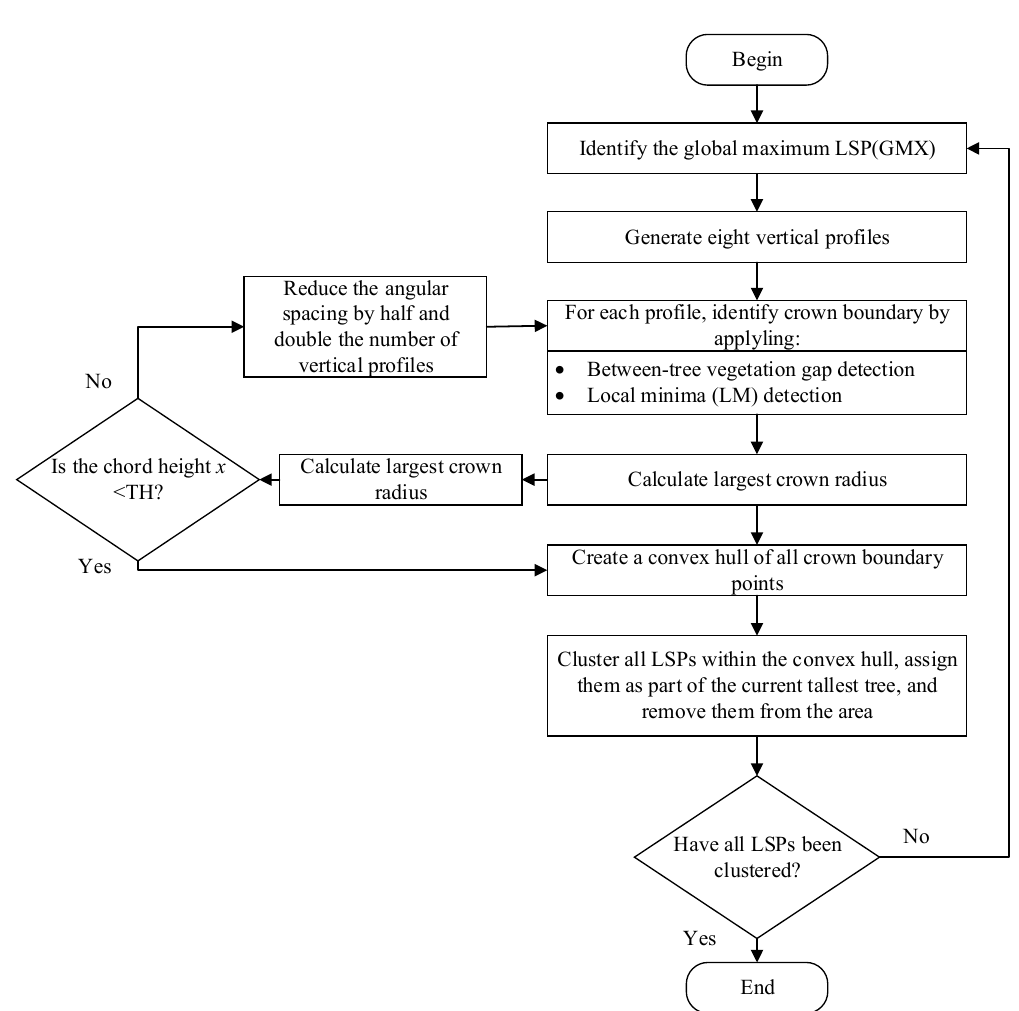
Figure 6. Flowchart of the improved DSM-based segmentation method .